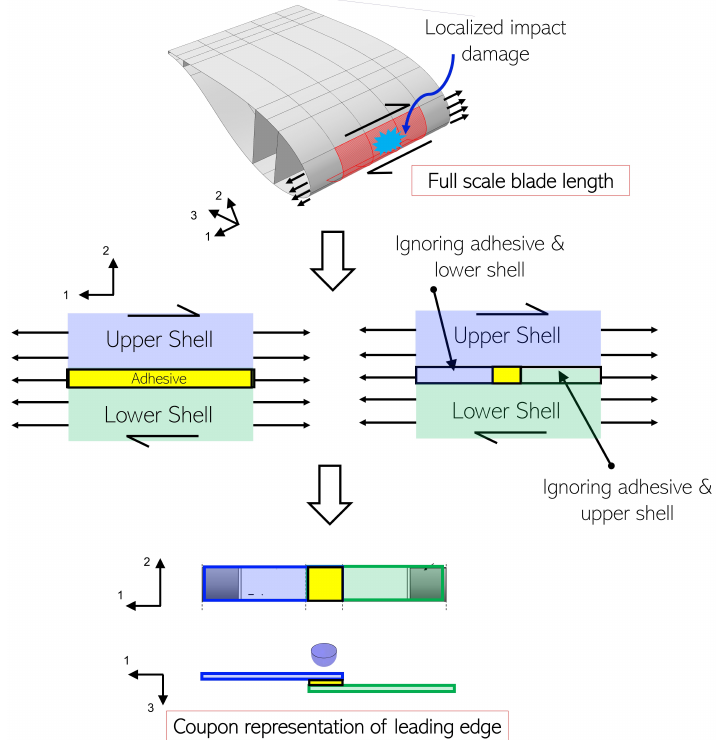
Figure 3. Single lap adhesive joint representation of leading edge at coupon